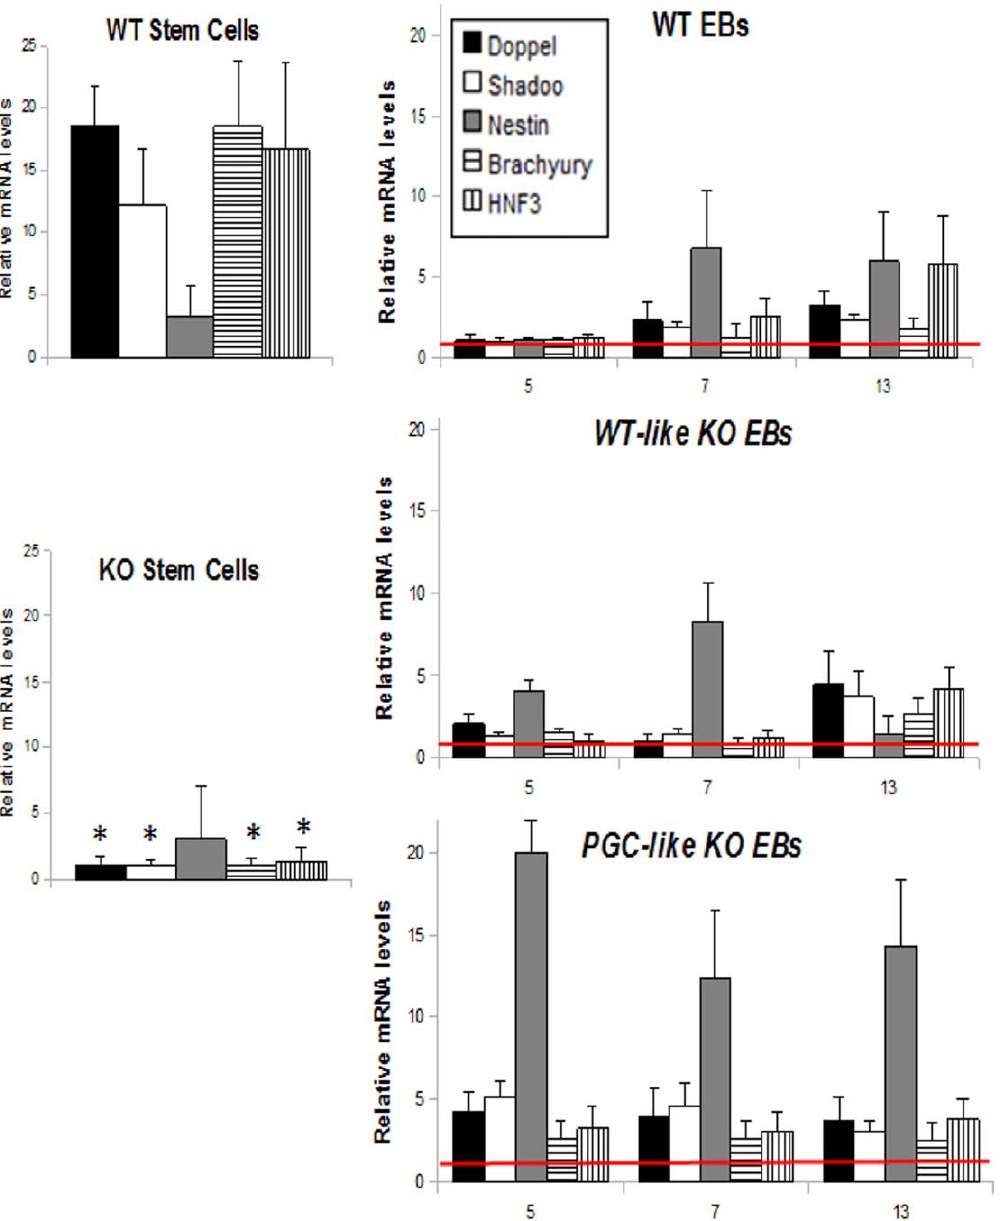
Figure 4. Differentiation transcription behaviour of the WT and Prnp -null cell lines. mRNA expression patterns of PRNP related proteins (Doppel and Shadoo) and early markers of endoderm ( Hnf3 ), mesoderm ( Brachyury -T- ) and ectoderm ( Nestin ) in WT and KO stem cells and in WT, WT- like KO and PGC-like KO EBs during differentiation (Days 5, 7 and 13). (* indicates statistical differences for the transcription of each gene between WT and KO ESC at P , 0.05) (Error bars,